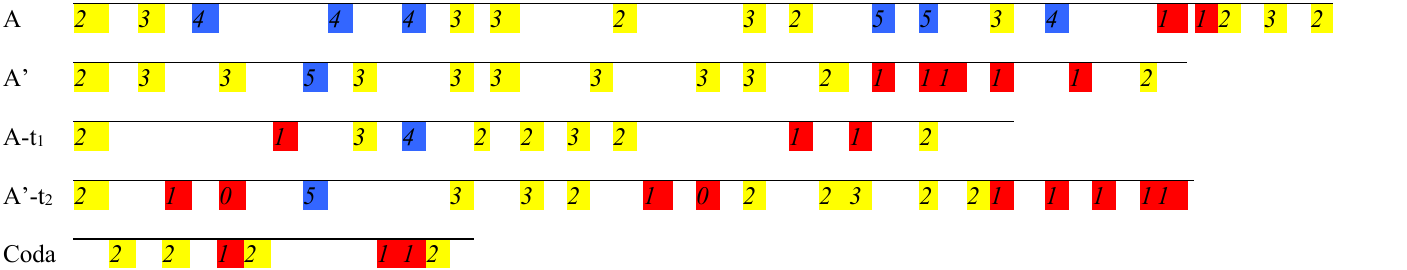
Figure 16. Overview of the anticipation measured with the ESS for Player #3 (127bpm). ESS categories are color-coded with red for an ESS of 0 to 1; yellow for 2 to 3; blue for 4 and more.